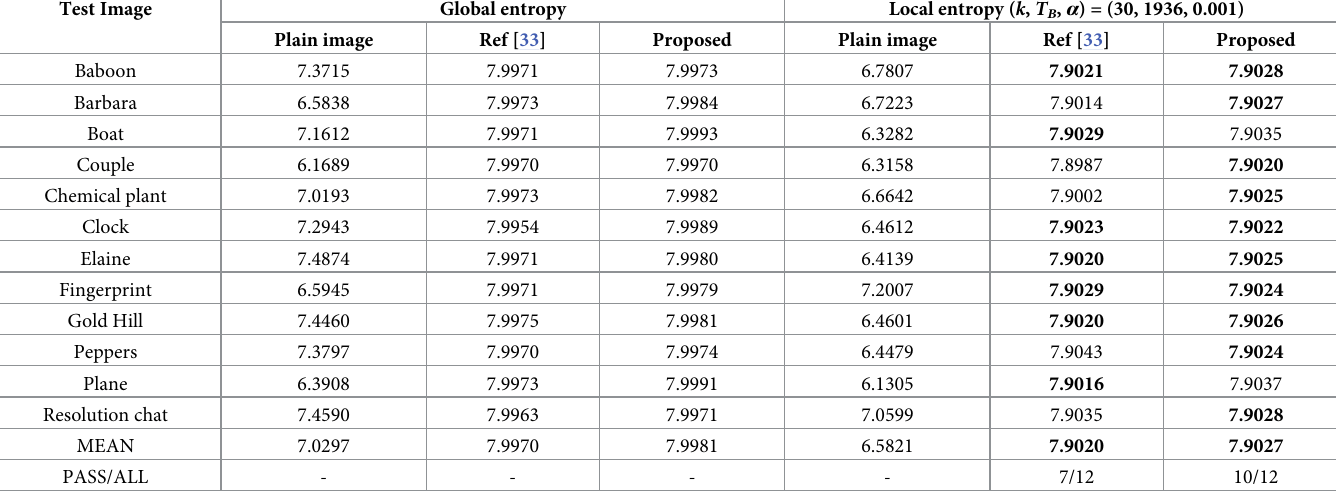
Table 5. Analysis and comparison of global entropy and local entropy between original image and encrypted image. Test